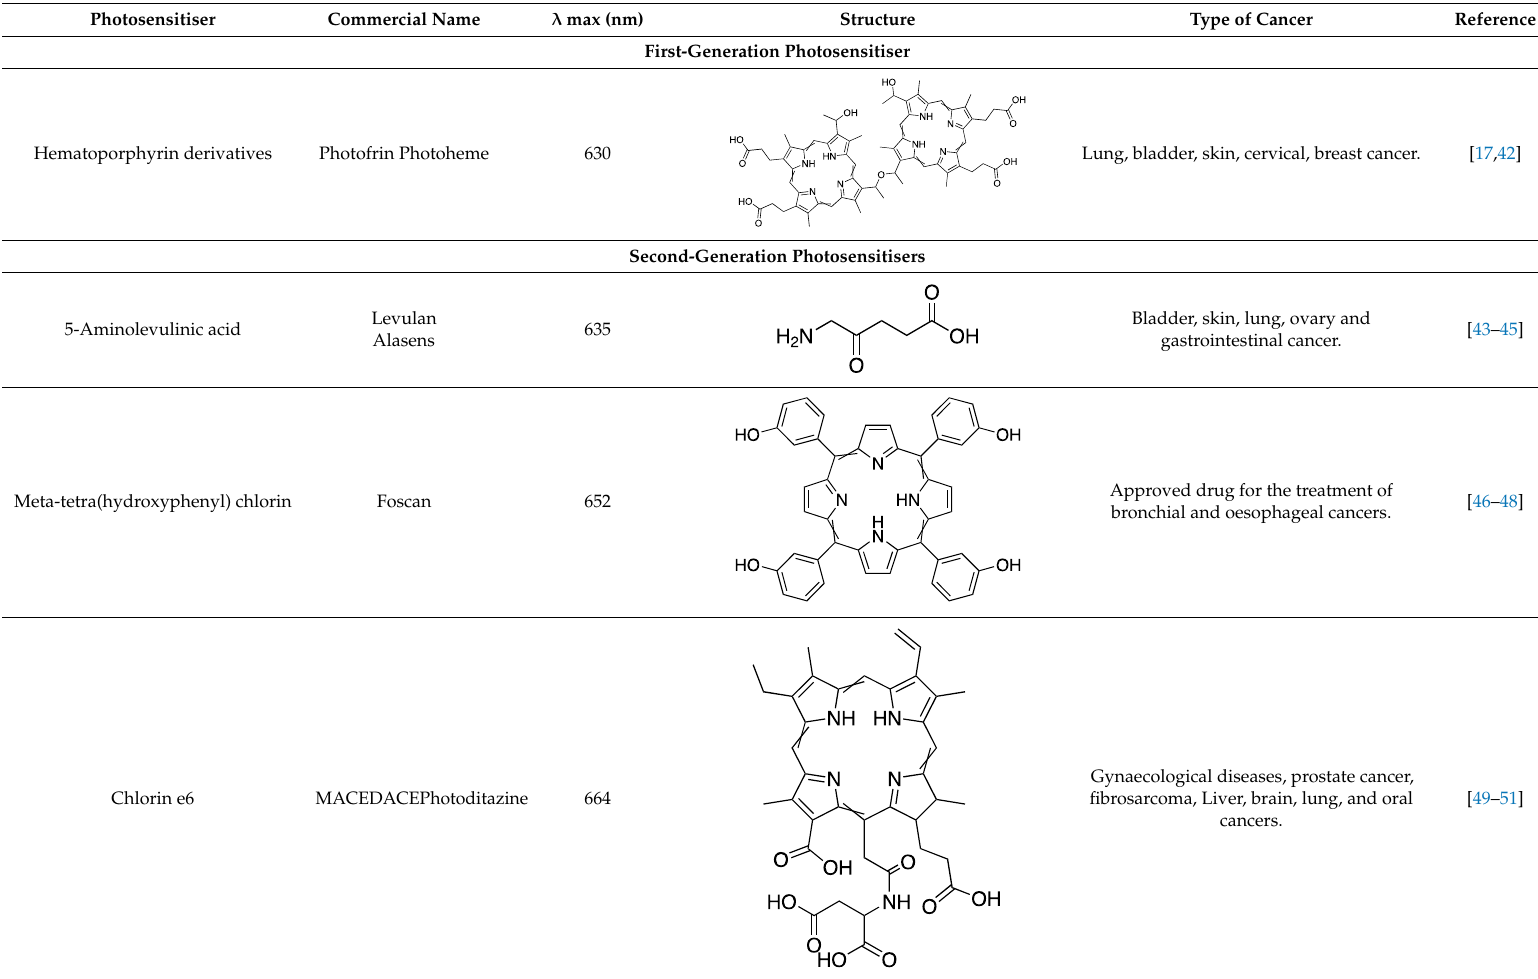
Table 1. List of photosensitisers used in photodynamic therapy of various cancers.